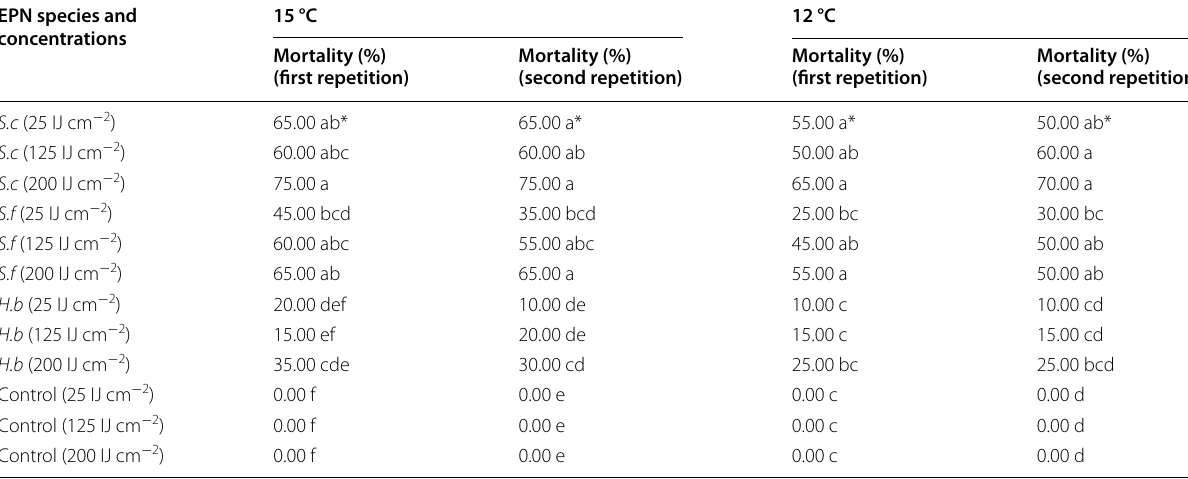
Table 1 Percent mortality of wheat stink bug adults to three different concentrations of entomopathogenic nematodes (EPNs) from isolated Turkey [ Steinernema carpocapsae (Black sea isolate) ( S.c ) , S. feltiae (isolate 09-31) (Aydin isolate) ( S.f ), and Heterorhabditis bacteriophora (isolate 09-43) (Aydin isolate) ( H.b )] on wheat stink bug, Aelia rostrata adults at 15 °C and 12 °C (first and second repetitions) ( P <